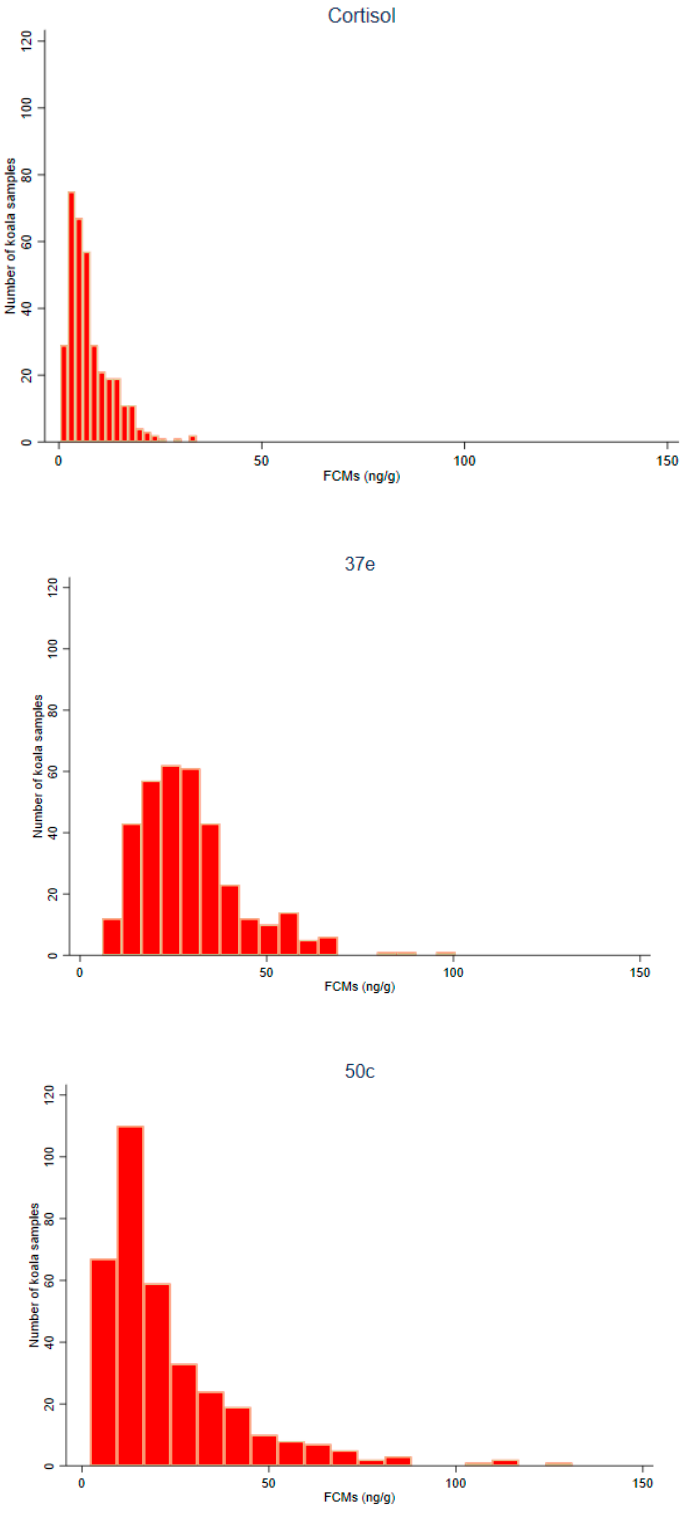
Figure 1. Histograms of FCM (faecal cortisol metabolite) values (ng/g) measured with the cortisol, 37e (5 α -pregnane-3 β ,11 β ,21-triol-20-one) and 50c (tetrahydrocorticosterone) EIAs (enzyme immunoassays).